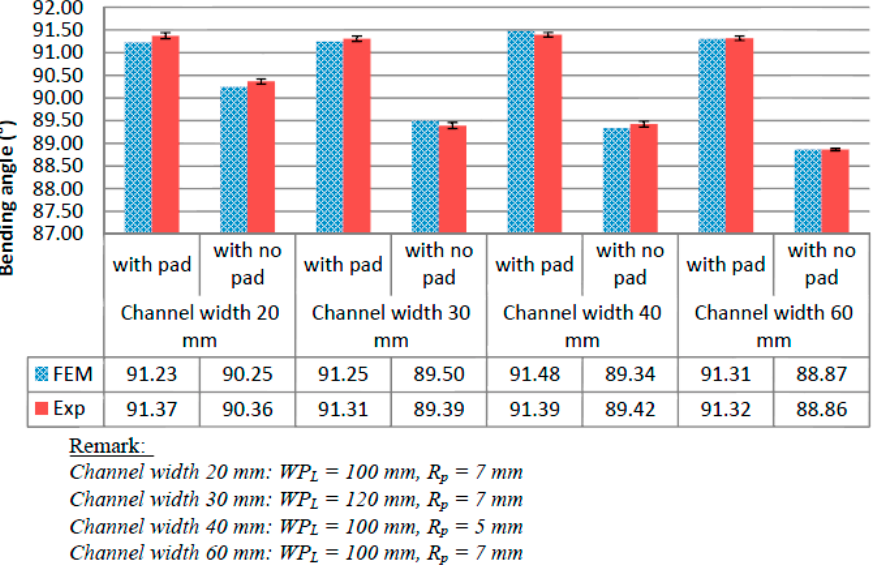
Figure 15. Comparison of the bending angle between the FEM simulations and the experimental results ( θ : 90°, t : 3 mm, R ud : 5 mm).